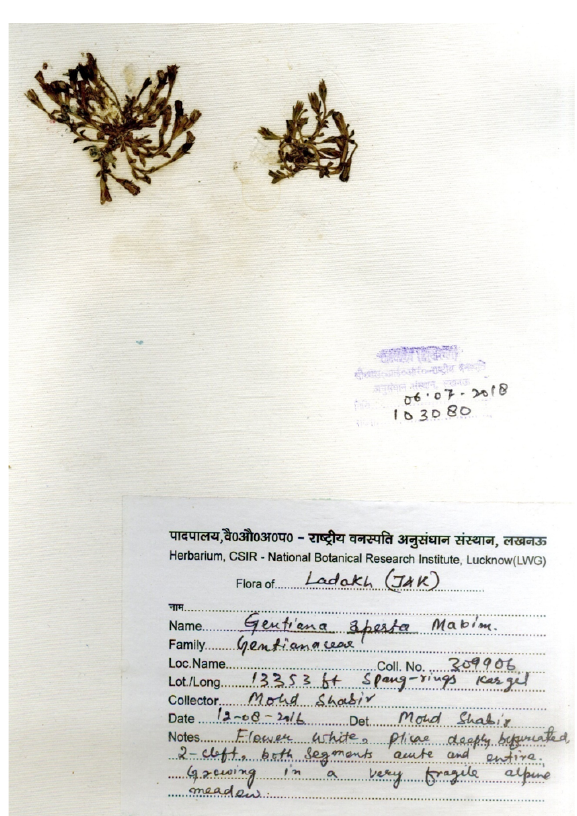
Image 2. Map showing existing and new localities of Gentiana aperta